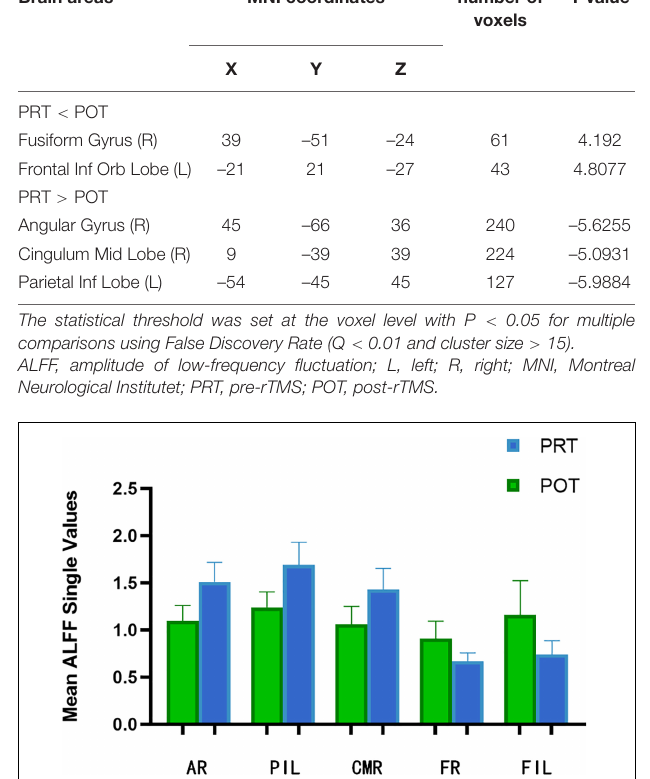
TABLE 2 | Brain areas with significantly different amplitude of low-frequency fluctuation (ALFF) between groups. Brain areas MNI coordinates